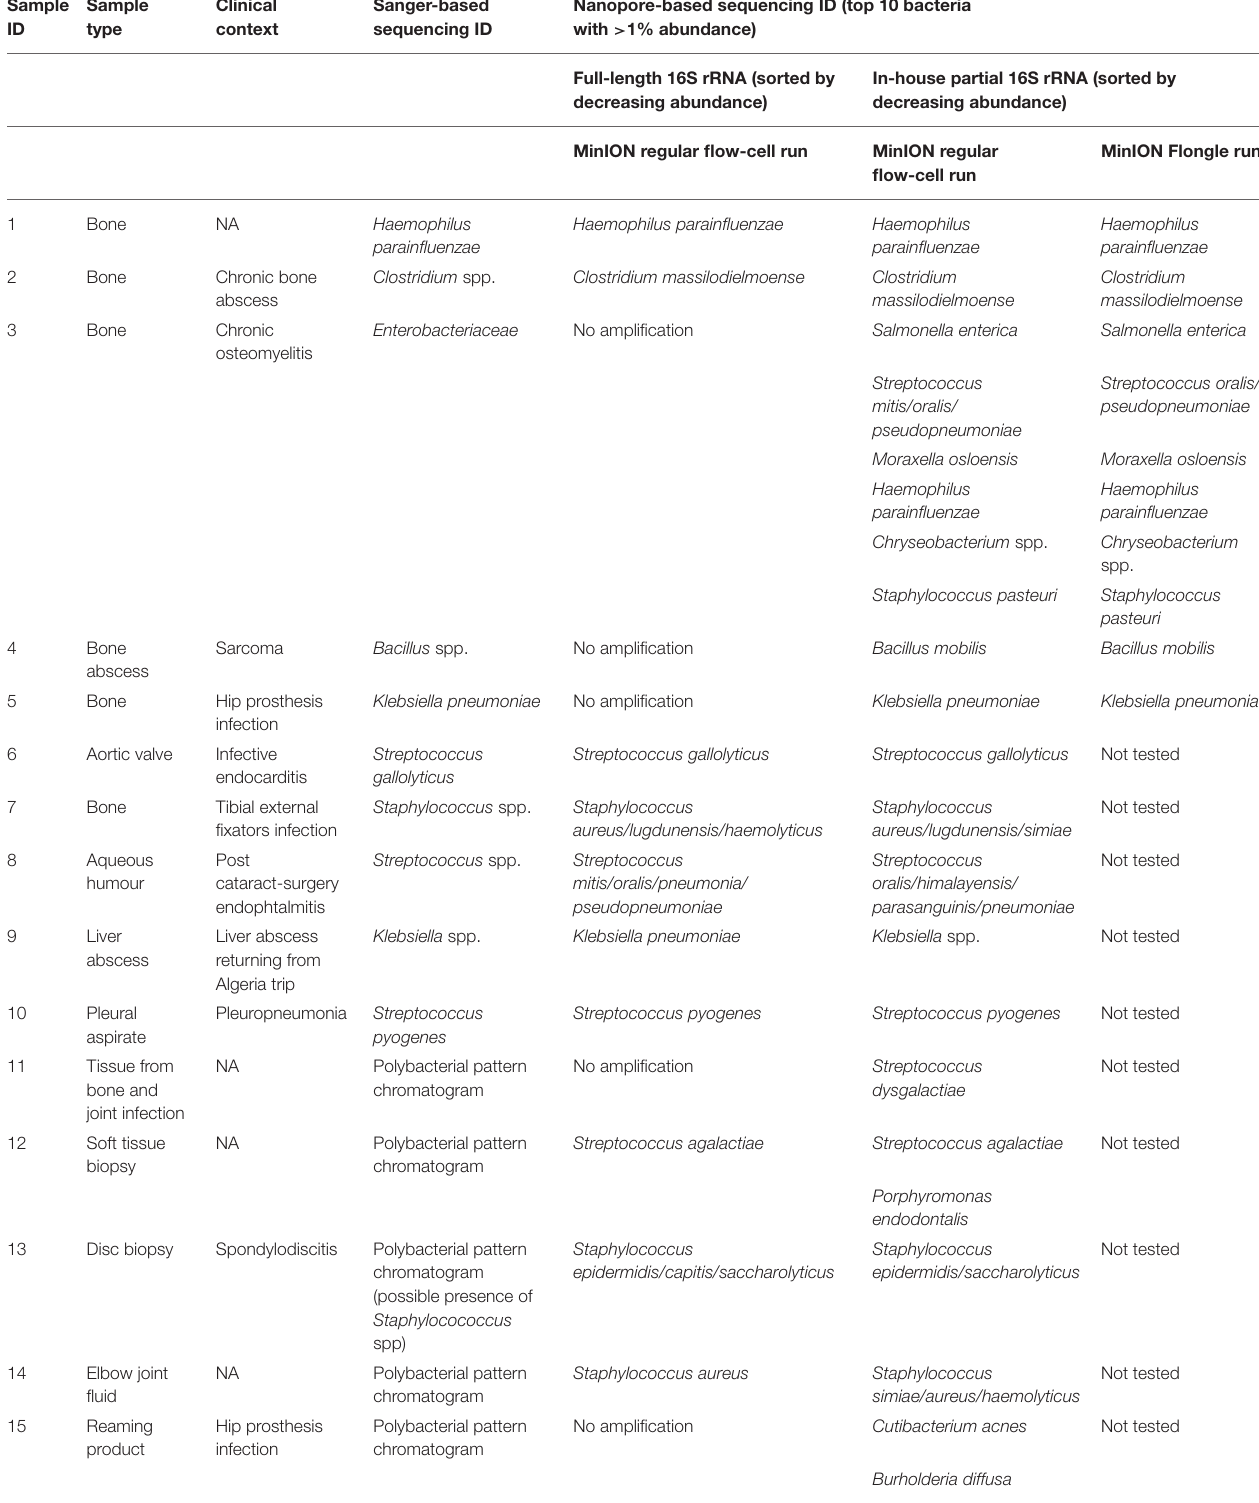
TABLE 1 | Characteristics and bacterial identifications based on Sanger sequencing, full-length 16S rRNA Nanopore sequencing, and in-house partial 16S rRNA Nanopore sequencing. Sample